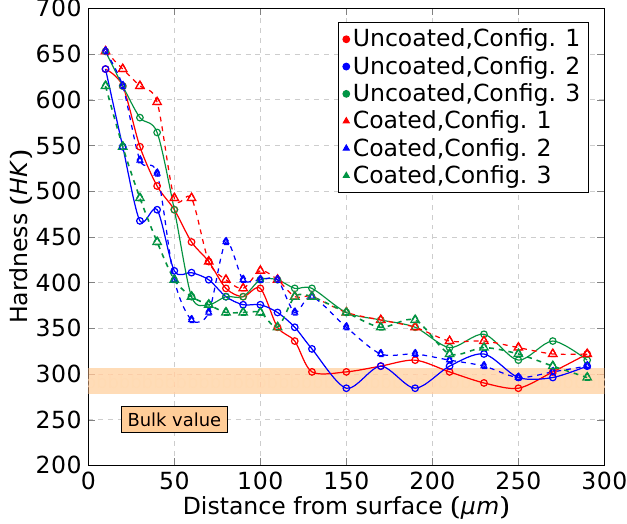
Figure 15. Knoop microhardness profile of the machined workpiece.